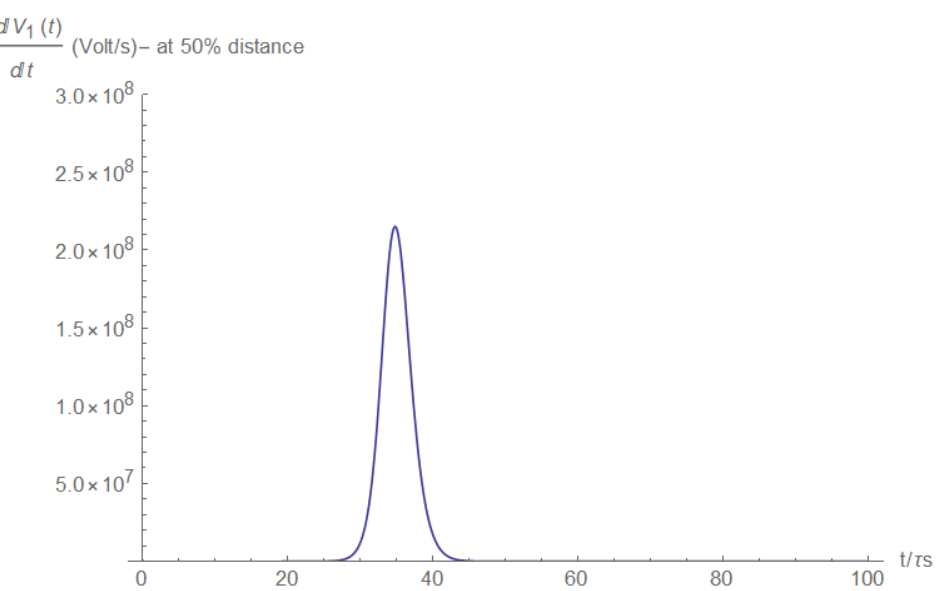
Figure A28. Voltage derivative at half the distance between the source and the